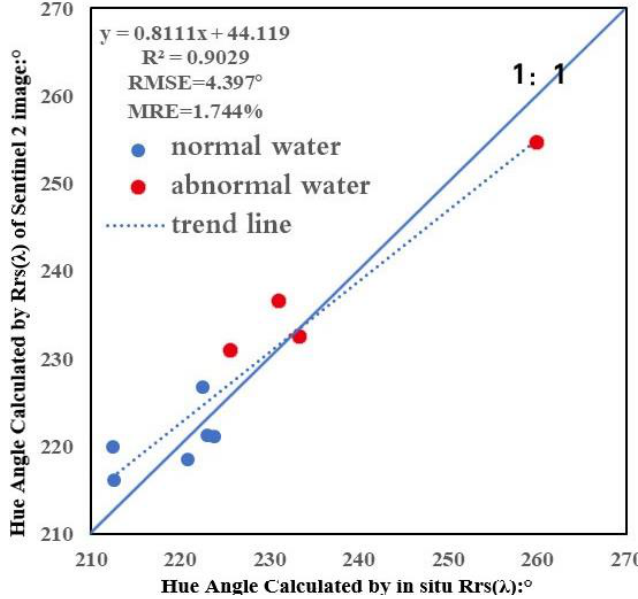
Figure 6. Scatterplots showing the derivation accuracies of hue angle α from remote-sensing reflectance of the Sentinel-2 image in comparison with in situ remote-sensing reflectance.